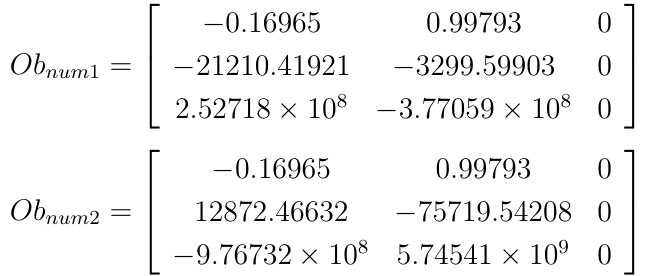
Figure 14. Frequency response of the closed loop PV system with G